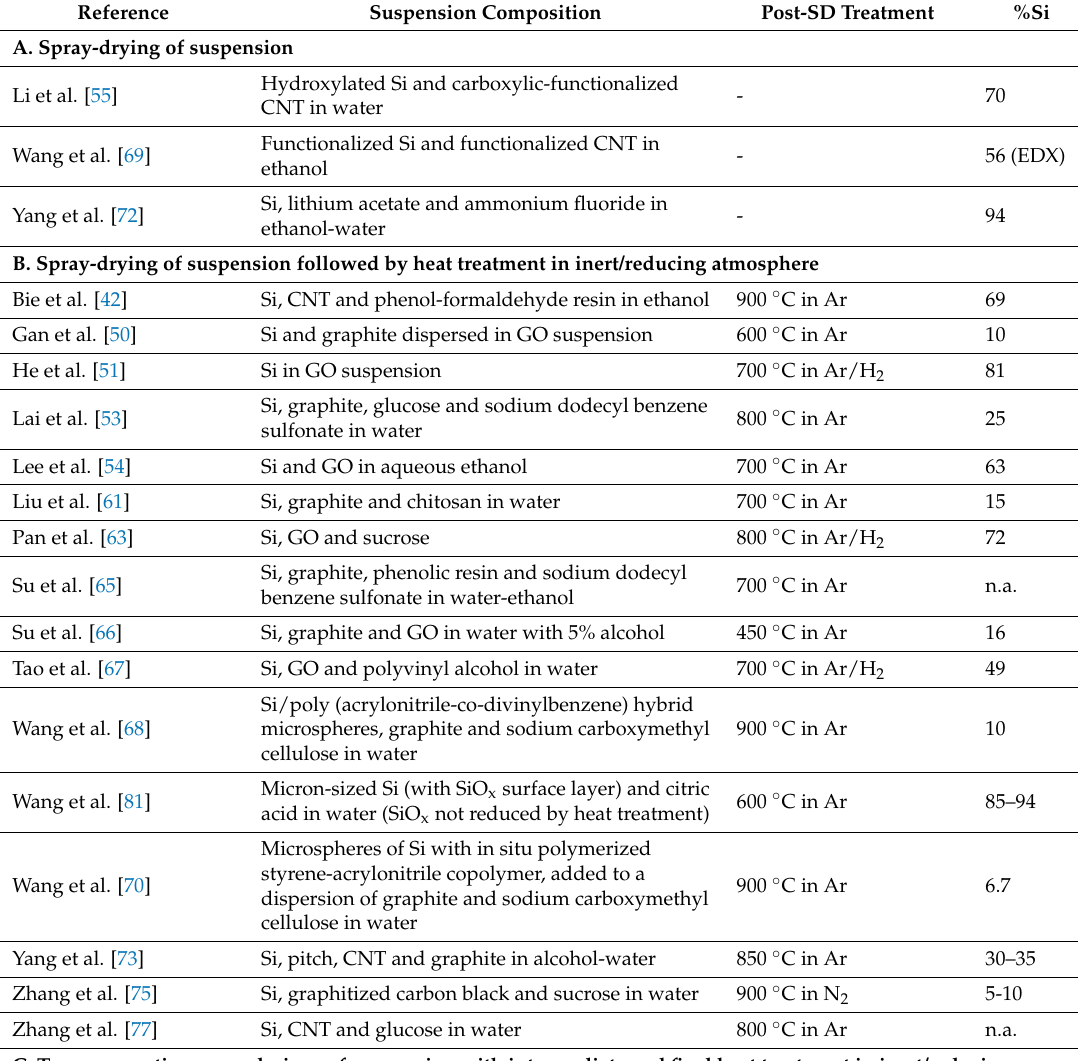
Table 6. Spray-drying in the preparation of Si-carbon composites, starting from Si. For synthesis of Si/C composites starting from SiO 2 , see [48,49]. Unless otherwise stated, Si is “nano” (either purchased as such or ground by ball-milling). CNT = carbon nanotubes; GO = graphene oxide; n.a. = not